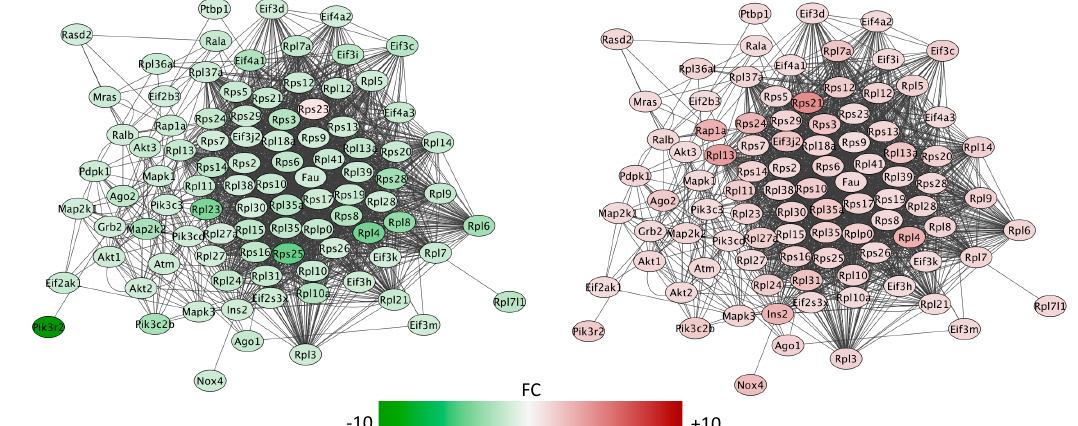
Figure 6. Eukaryotic initiation factor 2 (EIF2) signaling pathway. Genes with overlapping actions observed in ( A ) Tat − / Meth vs. Tat − / Sal, and in ( B ) Tat +/ Meth vs. Tat − / Meth and assigned to EIF2 signaling were loaded into Cytoscape via Genemania; significant changes associated to assigned comparisons ( p < 0.01) were visualized by loading the node attributes table. Tat − / Meth vs. Tat − / Sal p = 7.37 × 10 − 12 and Tat +/ Meth vs. Tat − / Meth p = 6.03 × 10 − 13 , with 58% and 56.4% overlap, respectively.